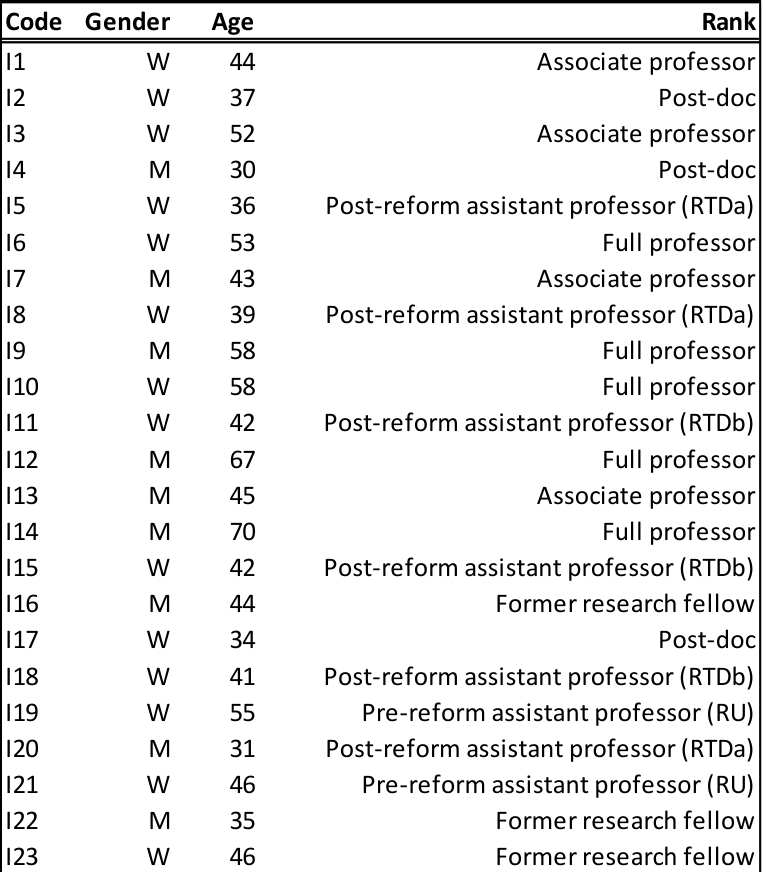
Table 1. List of interviewees: gender, age and